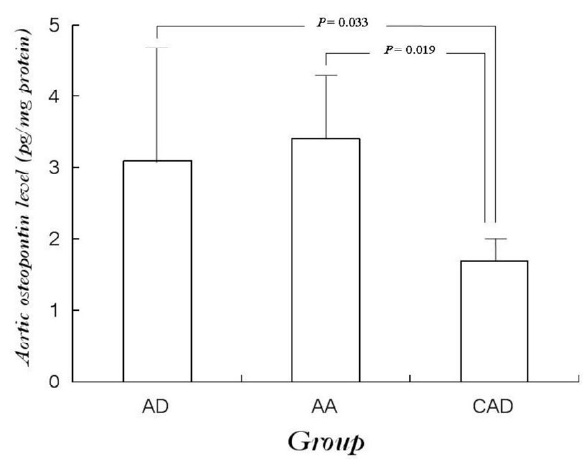
Fig. 5 - The osteopontin values in the aortic tissue detected by ELISA. P = 0.989 for AD vs. AA, P= 0.033 for AD vs. CAD, and P = 0.019 for AA vs. CAD. AA: aortic aneurysm; AD: aortic dissection; CAD: coronary artery disease